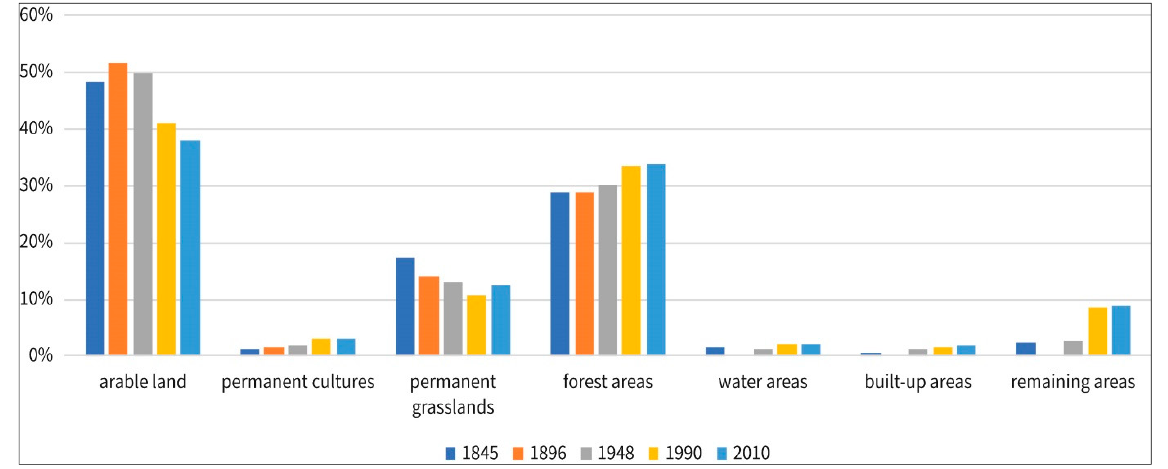
Figure 6. Area of land use classes in Czechia in years 1845, 1948, 1990, and 2010 (in %). (b) Landscape changes were influenced by a number of different factors over the whole period 1845–2010 (Figures A1–A4). The driving forces that likely had the most sig-